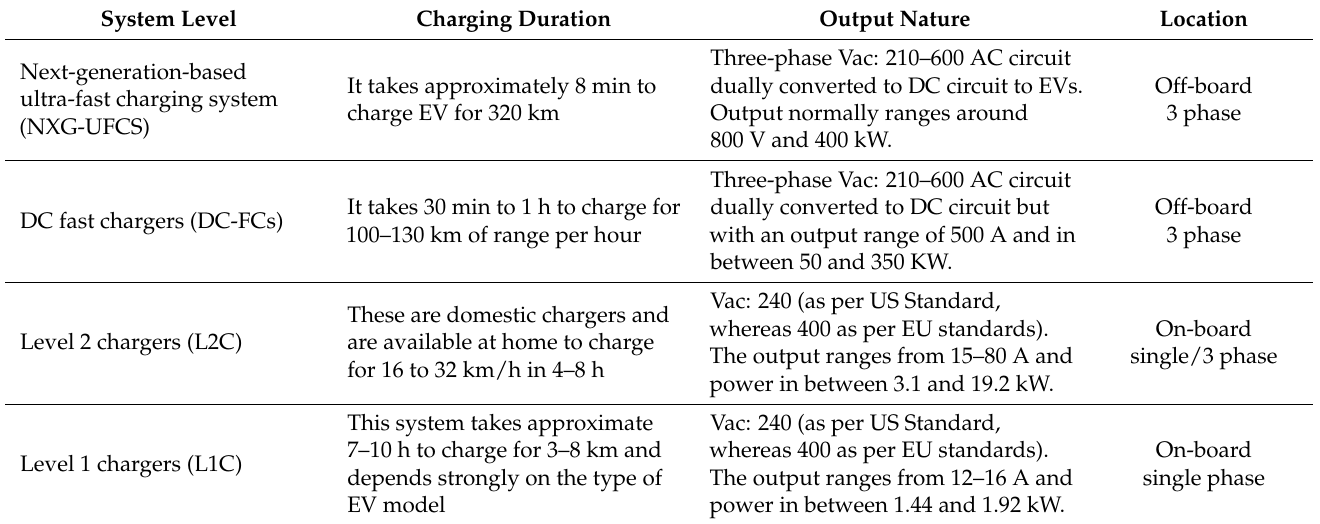
Table 1. Different charging level systems